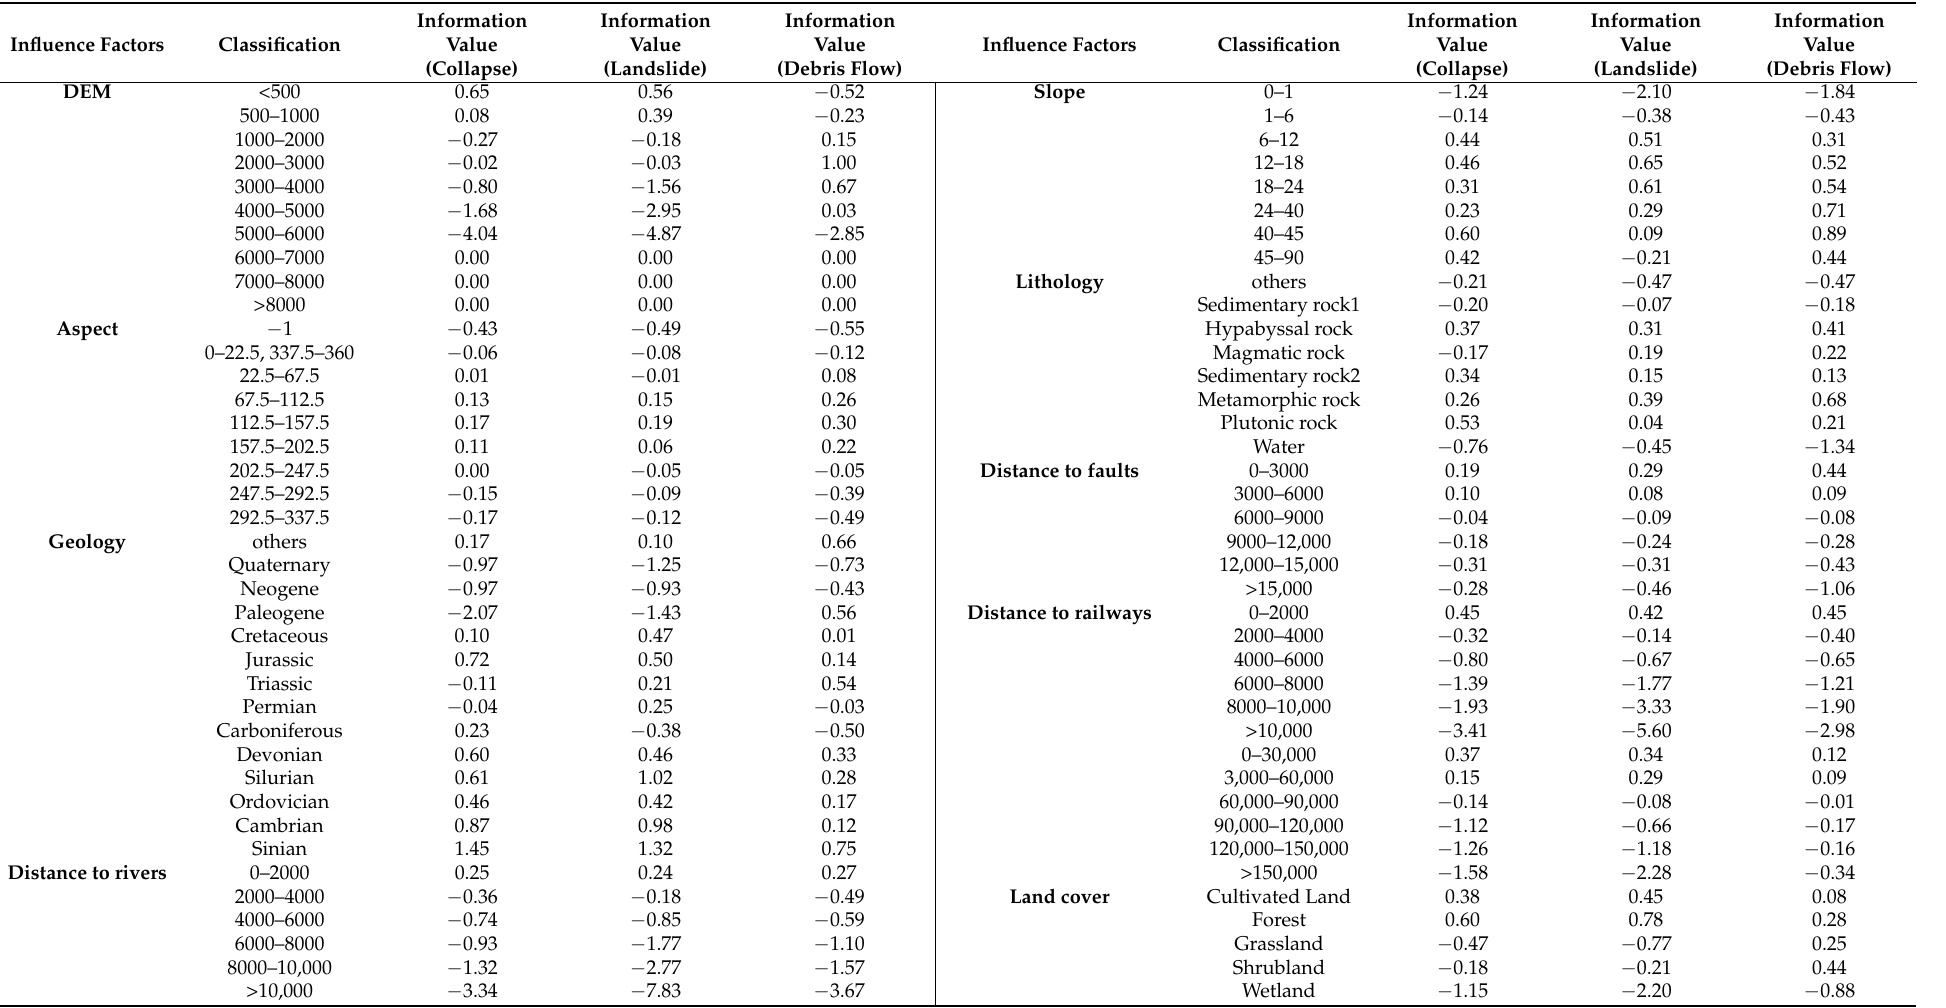
Table 3. The Information Values of Influence